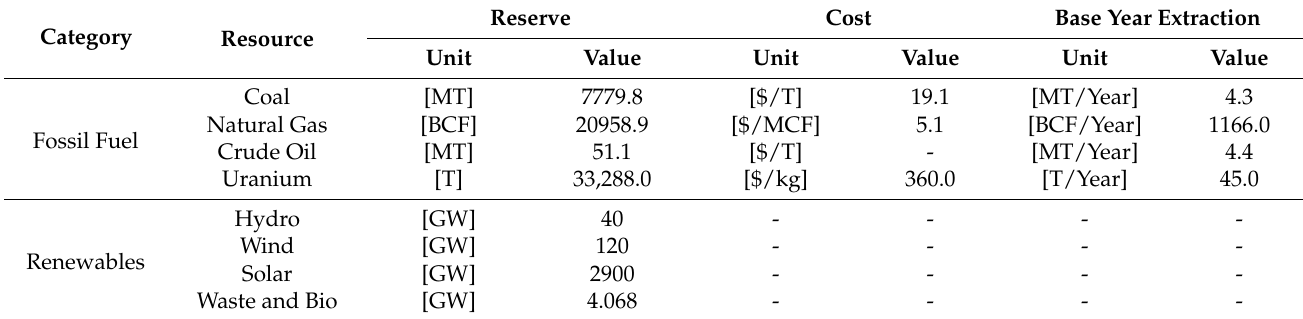
Table 14. Resource cost and availability data [9,32,46,47].